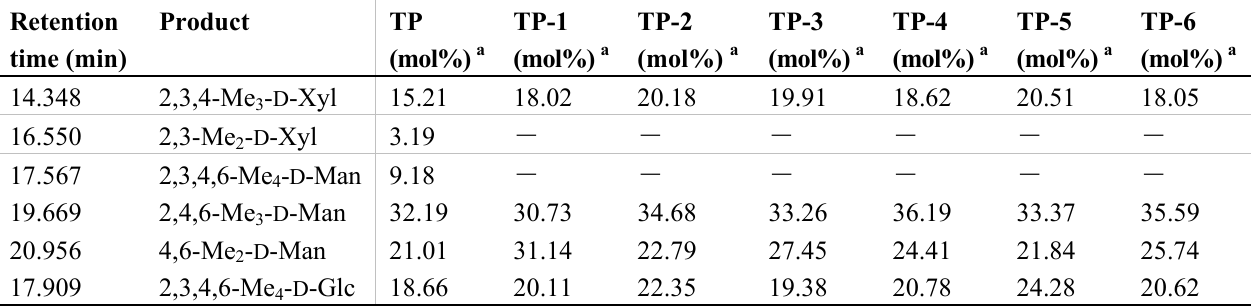
Table 2. Methylation analysis of TP-1, TP-2, TP-3, TP-4, TP-5 and